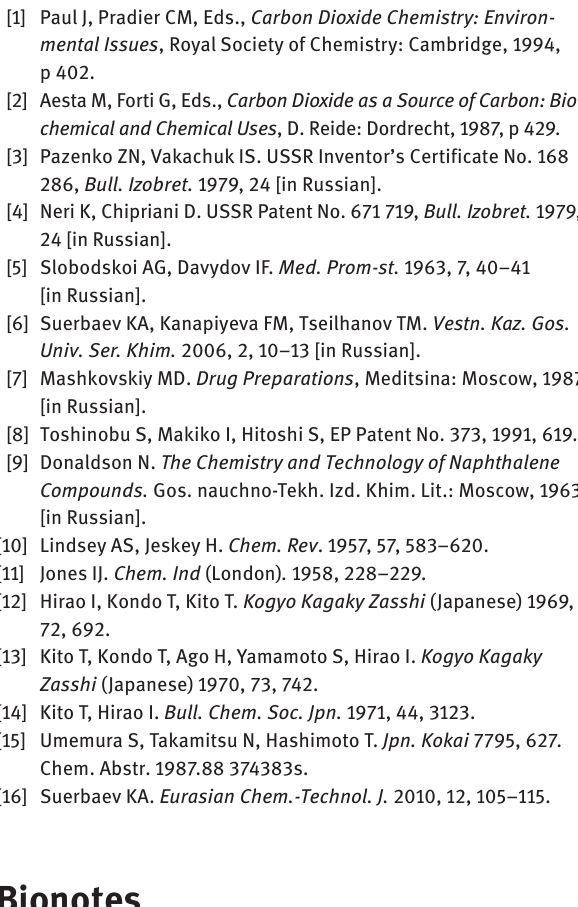
= 10 atm, τ = 5 h). co 2